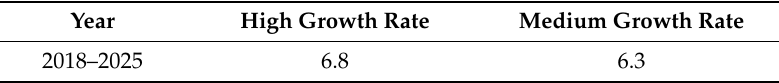
Table 2. Values set for the growth rate of GDP from 2018 to 2025 (%).